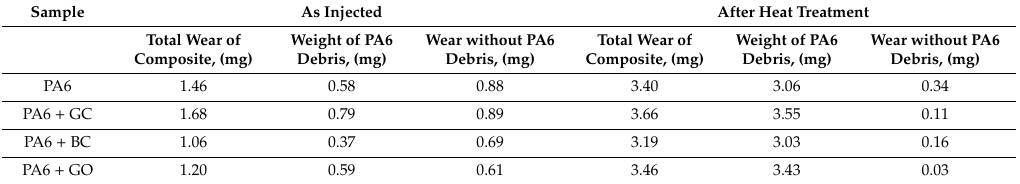
Table 5. Wear result of composites in pin-on-block test with reciprocating movement.